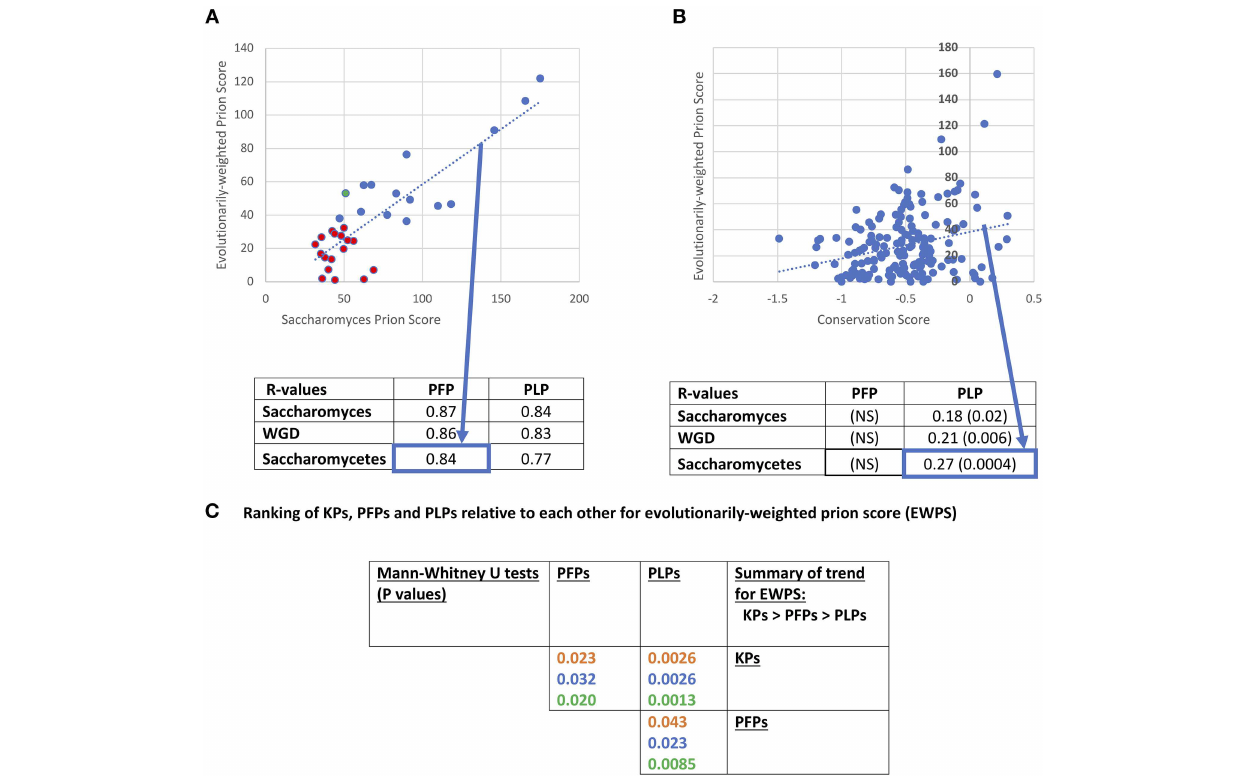
FIGURE 3 | Evolutionarily-weighted prion score (EWPS). (A) Scatterplot of the EWPS vs. the Saccharomyces cerevisiae prion score (SCPS) for the prion-forming protein set at the Saccharomycetes level. Only one has an EWPS > SCPS (green point). Seventeen of the domains have EWPS < the lowest value of SCPS for a known prion domain ( = 35.6 for PIN3). Below the plot is a tabulation of R -values of these correlations for the PFP and PLP sets at the three evolutionary levels. These are all significant at P < 0.000001. The percent sequence identity method for calculating the EWPS has been used, but the difference in results obtained with the bitscore method in all cases is minimal. “NS” stands for “not significant.” (B) Scatterplot of the EWPS vs. the conservation score at the Saccharomycetes level for the prion-like protein set. Below the plot is a tabulation of R-values for the PFP and PLP sets at the three evolutionary levels. The significant P -values are in brackets. (C) Ranking of KPs, PFPs and PLPs relative to each other for evolutionarily-weighted prion score (EWPS). Tabulation of results of Mann-Whitney U -tests for comparison of the EWPS scores of the PFP, PLP and KP sets. Colour coding is as in Figure 1